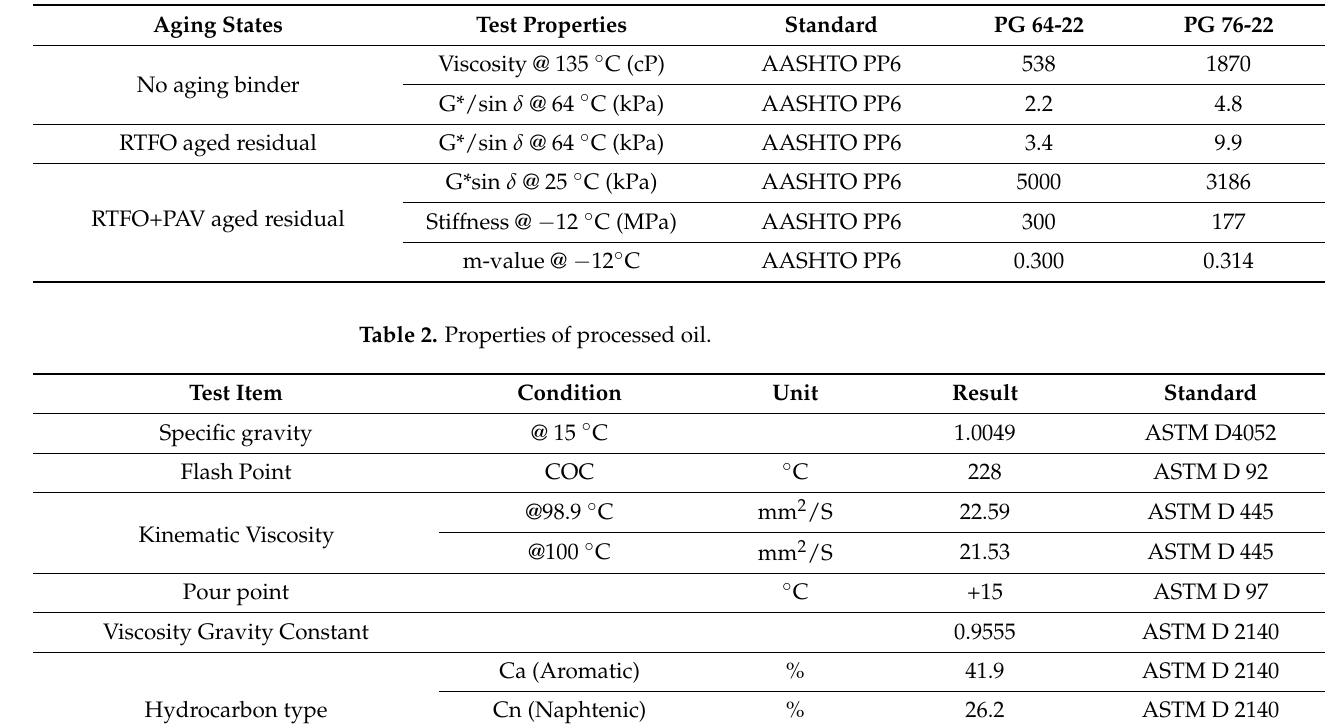
Table 1. Properties of asphalt binders (PG 64-22 and PG 76-22).